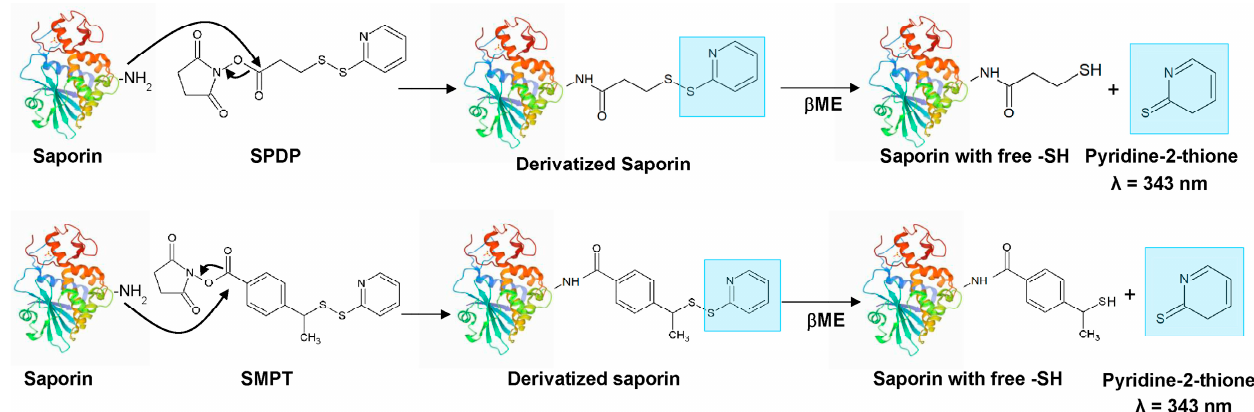
Table 2. Determination of the number of thiol groups (-SH) introduced per protein molecule of saporin derivatized with SPDP or SMPT. Calculation Scheme Formula 1—Concentration of inserted -SH groups